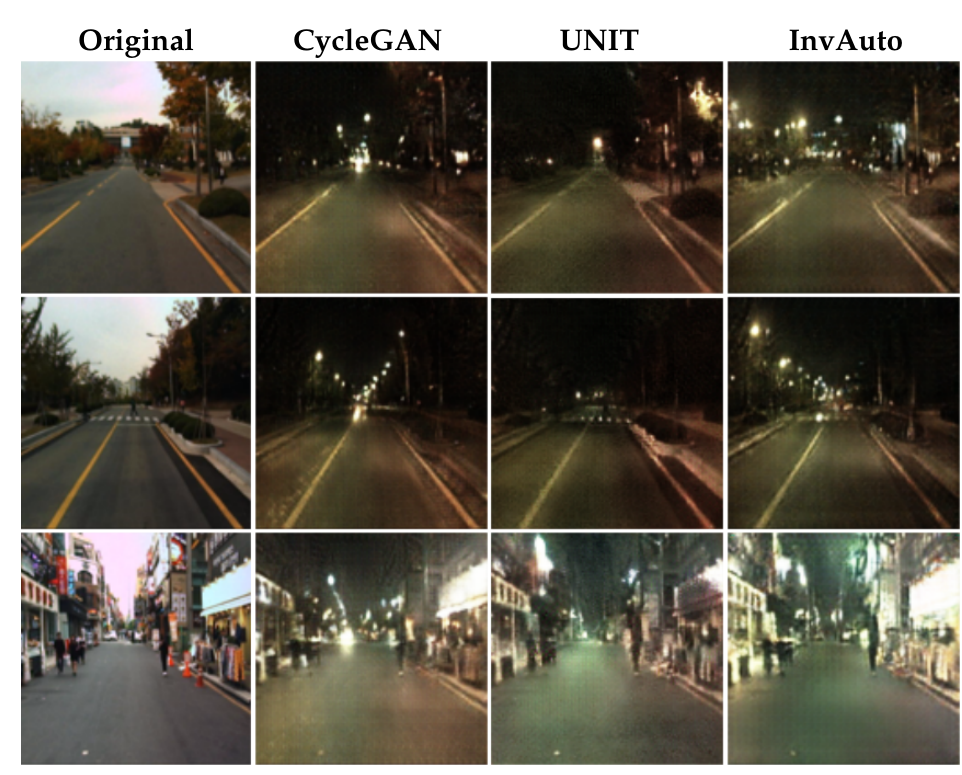
Figure A5. Day-to-night image conversion.